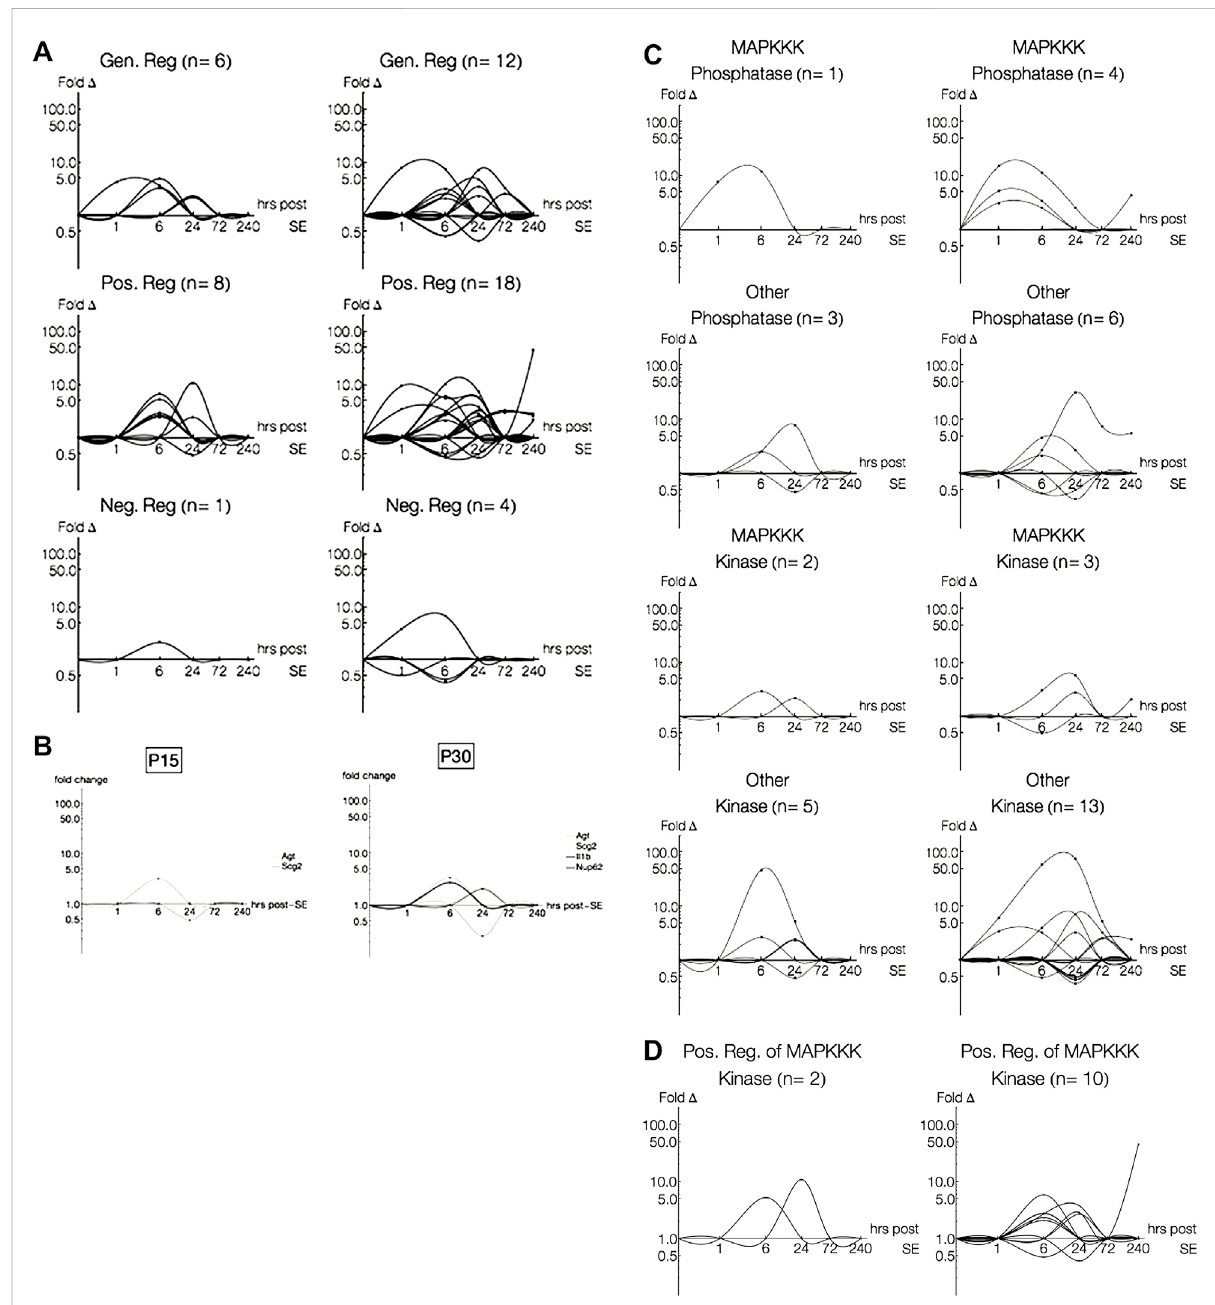
FIGURE 8 Log-Log plotsofdifferentialgeneexpression(foldchange).Lines,eachrepresenting asinglegene,were fi ttedusingsecondorderinterpolation for ease of visualization. (A) Log-Log plots of differential gene expression (fold change) of genes regulating pathways. Most genes differentially expressed in P15 (left) and P30 (right) only regulate a single pathway, even amongst multiple-pathway annotated genes. (B) Log-Log plots of differential gene expression (fold change) of genes regulating pathways. Only four genes differentially expressed in P15 or P30 were annotated as regulating multiple pathways. (C) Log-Log plots of differential gene expression (fold change) of phosphatases and kinases in P15 (left) and P30 (right). (D) Log-Log plots of differential gene expression (fold change) of positive regulators of phosphatases and